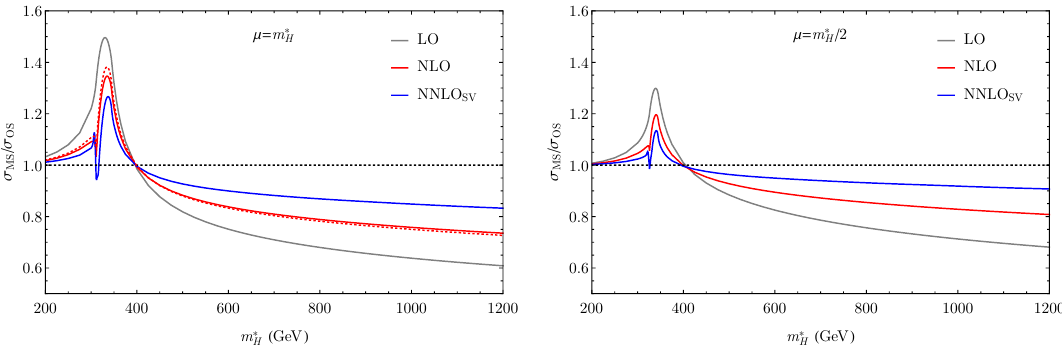
Figure 1 . Ratio of the off-shell Higgs production cross section in the MS scheme to the corre- sponding OS prediction, as a function of m ∗ NNLO SV (blue), for a scale µ = m ∗ prediction is also shown (red-dotted